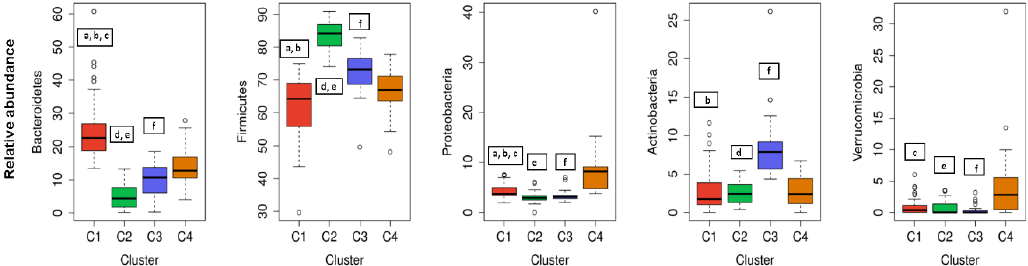
Figure 2. The cluster analysis showing the presence of four distinct community types of gut bacteria phyla.